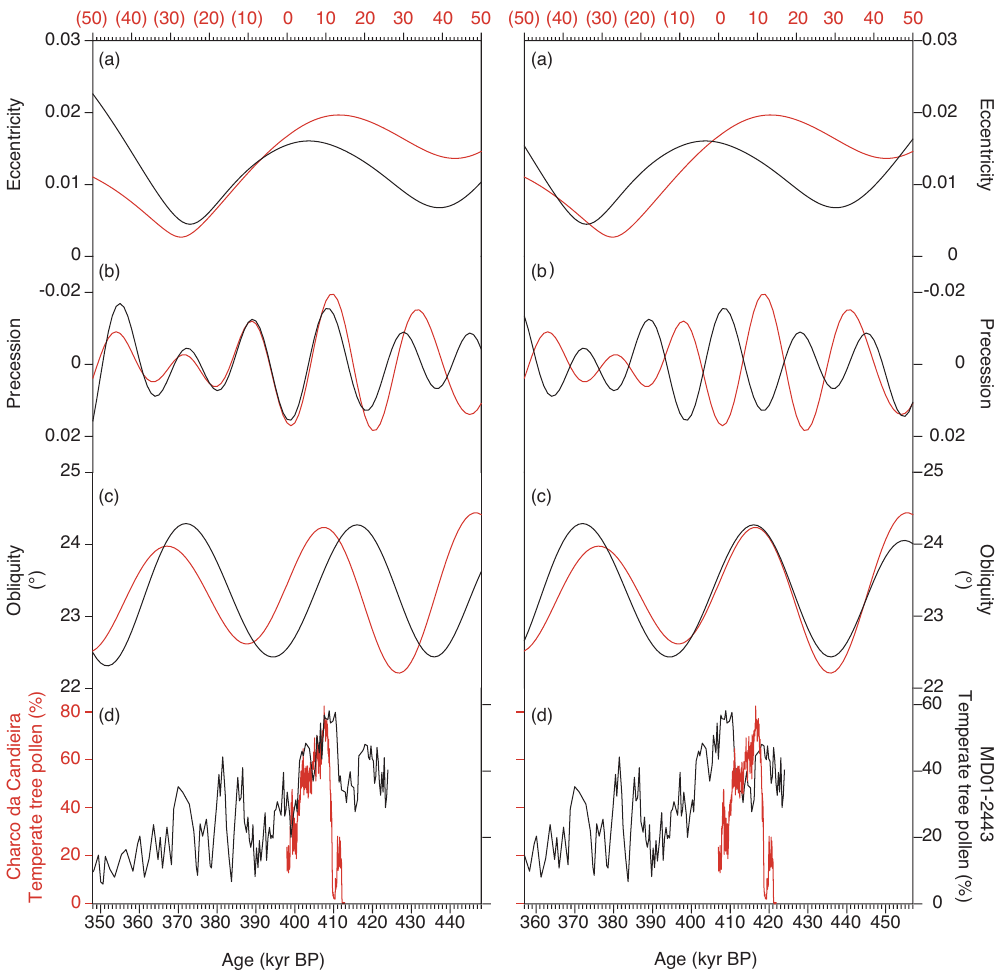
Fig. 5. Comparison of two alignment schemes between the past and future 50kyr (red) and a 100-kyr interval encompassing MIS 11 (black), using pollen records from Portugal. Left panel shows synchronization of the precession signal and right panel synchronization of the obliquity signal. (a) eccentricity (Berger and Loutre, 1991); (b) precession index, plotted on an inverse vertical axis (Berger and Loutre, 1991); (c) obliquity (Berger and Loutre, 1991); (b) δD composition of ice in the EDC ice core, Antarctica (Jouzel et al., 2007), plotted on the EDC3 timescale; (c) atmospheric CH 4 concentration from Antarctic EDC ice core (Loulergue et al., 2008), plotted on the EDC3 timescale; (d) temperate tree (Eurosiberian and mediterranean taxa) pollen percentages in Portugal. The pollen records used are: MIS 11 (black) from MD01-2443 (Tzedakis et al., 2009); and Lateglacial/Holocene (red) from Charco da Candieira (van der Knaap and van Leeuwen, 1995, 1997) (see text for details of age models). The latter is selected over the pollen record from marine sequence SU8118 (see Fig. 4), because of its higher sampling resolution. Note that temperate tree pollen percentages in the marine sequence are generally lower than those at the terrestrial site. This is because marine records incorporate pollen from a variety of environments, including coastal areas, which leads to an overrepresentation of herbaceous taxa. Ages in parentheses denote thousand years after present (kyr